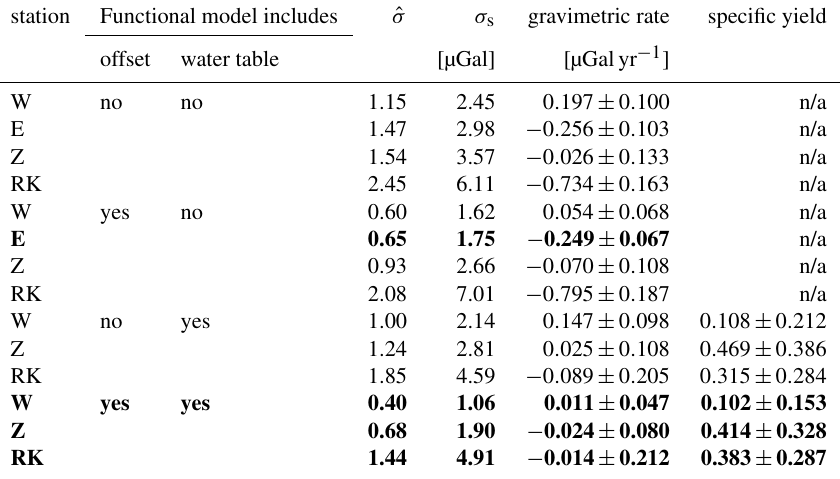
Table 1. Results of the analysis of the gravity records at stations Westerbork (W), Epen (E), Zundert (Z), and Radio Kootwijk (RK). ˆ σ is the a-posteriori standard deviation of unit weight; σ s is the RMS scatter around the estimated trend of the pre-processed gravity data corrected for instrumental offset (if offset = “yes”) and water table variations (if water table = “yes”). The given uncertainties for the gravimetric rate and the specific yield are a-posteriori standard deviations. The preferred solutions are highlighted in bold. station Functional model includes ˆ σ σ s gravimetric rate specific yield offset water table [µGal] [µGalyr − 1 ] W no no